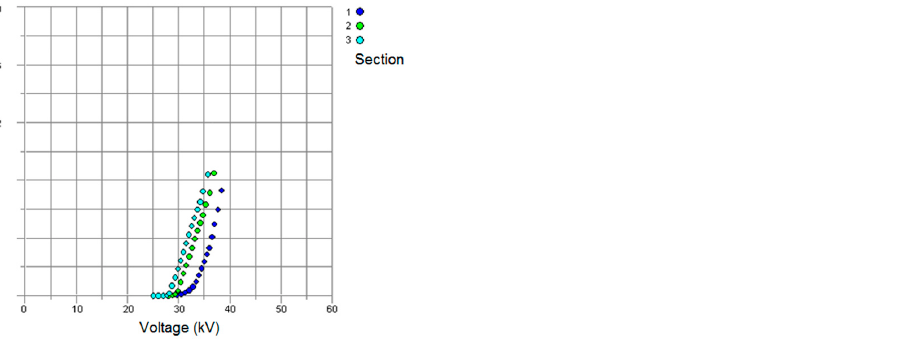
Figure 7. Current density-voltage characteristics at full-wave rectified voltage with a 2 mm dust layer on collecting surfaces.